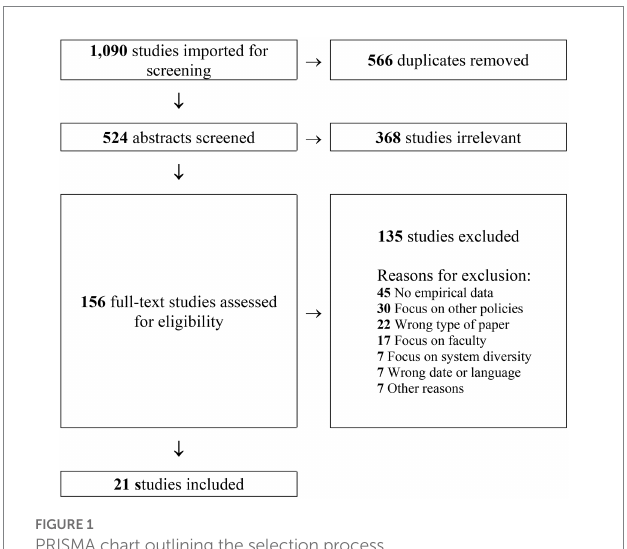
FIGURE 1 PRISMA chart outlining the selection